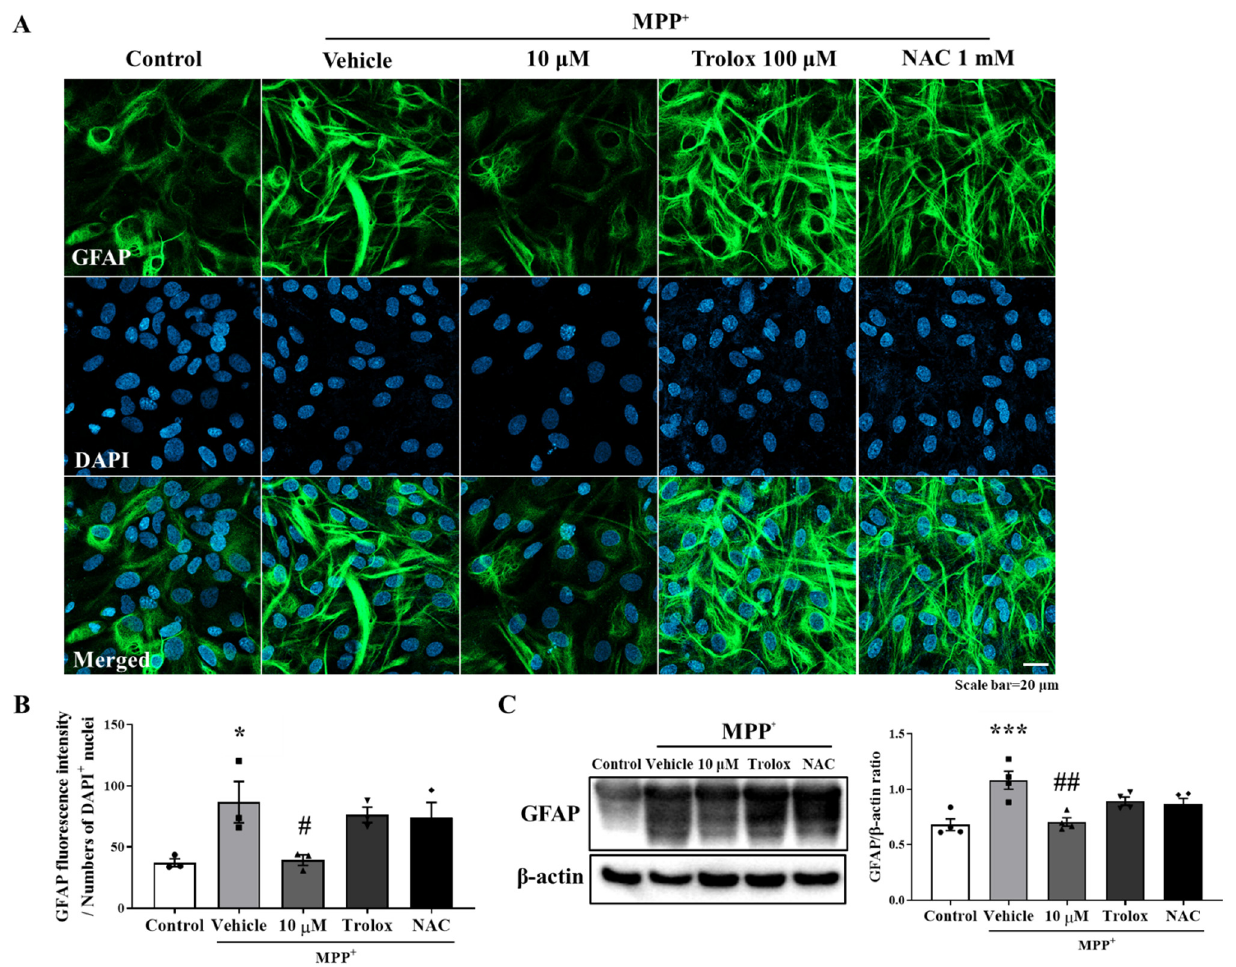
Figure 2. Anti-inflammatory activity of MHY2699 was not related to its antioxidant effect. ( A ) Representative images showing that antioxidants (Trolox and NAC) did not reduce MPP + -induced glial activation, which demonstrated that the anti-inflammatory effect of MHY2699 was independent of its antioxidant activity. Scale bar = 20 µ m. ( B ) Bar graph of GFAP fluorescence intensity. ( n = 3). ( C ) Western blot analysis also showed that antioxidants failed to regulate glial activation. ( n = 4). *** p < 0.001, * p < 0.05 vs. naïve control, ## p < 0.01, # p < 0.05 vs. MPP + controls (analyzed by ANOVA with Tukey’s multiple comparisons).